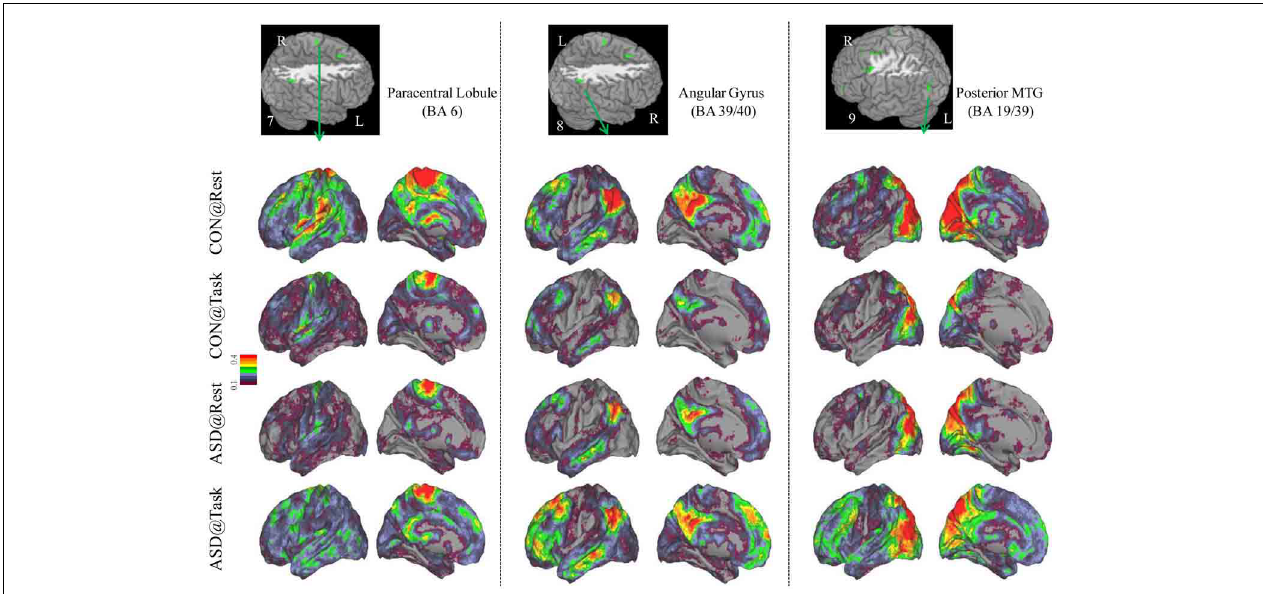
(left panel), right Angular Gyrus (BA 39/40) (middle panel) and Posterior MTG (BA 19/39) (right panel). Region numbers 7–9 on the left corner in the brain image correspond to the region number in Figure 1 .